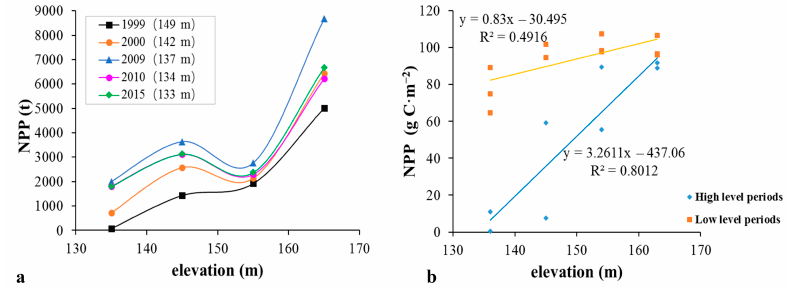
Figure 10. ( a ) Zonal statistics for NPP in different years and ( b ) NPP responses to different water levels. The numbers in parentheses following the years are the water level of each year.